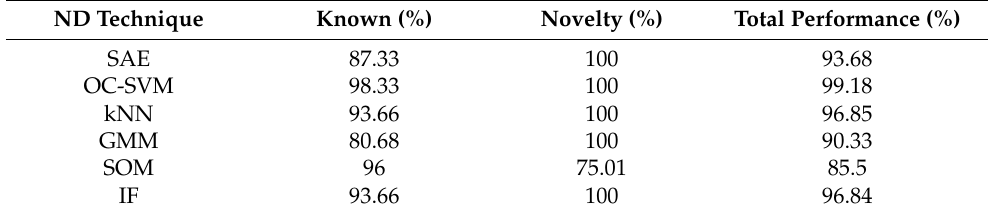
Table 10. Numerical results of the novelty detection obtained for the first case study of the WPG_DS.